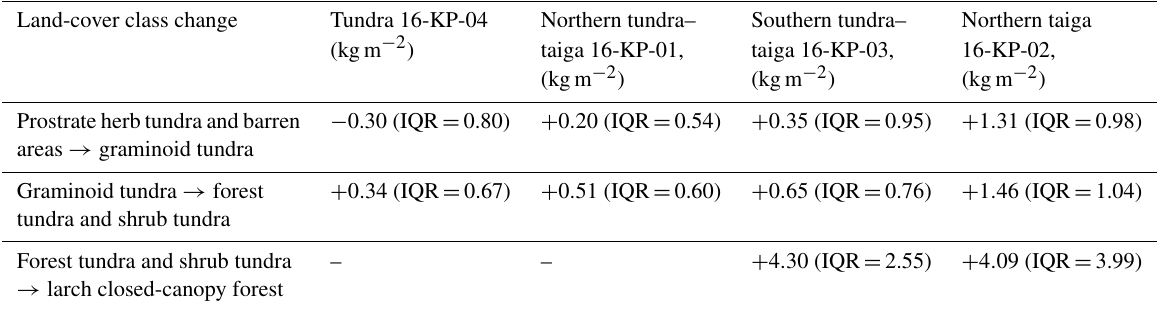
Prostrate herb tundra and barren areas → graminoid